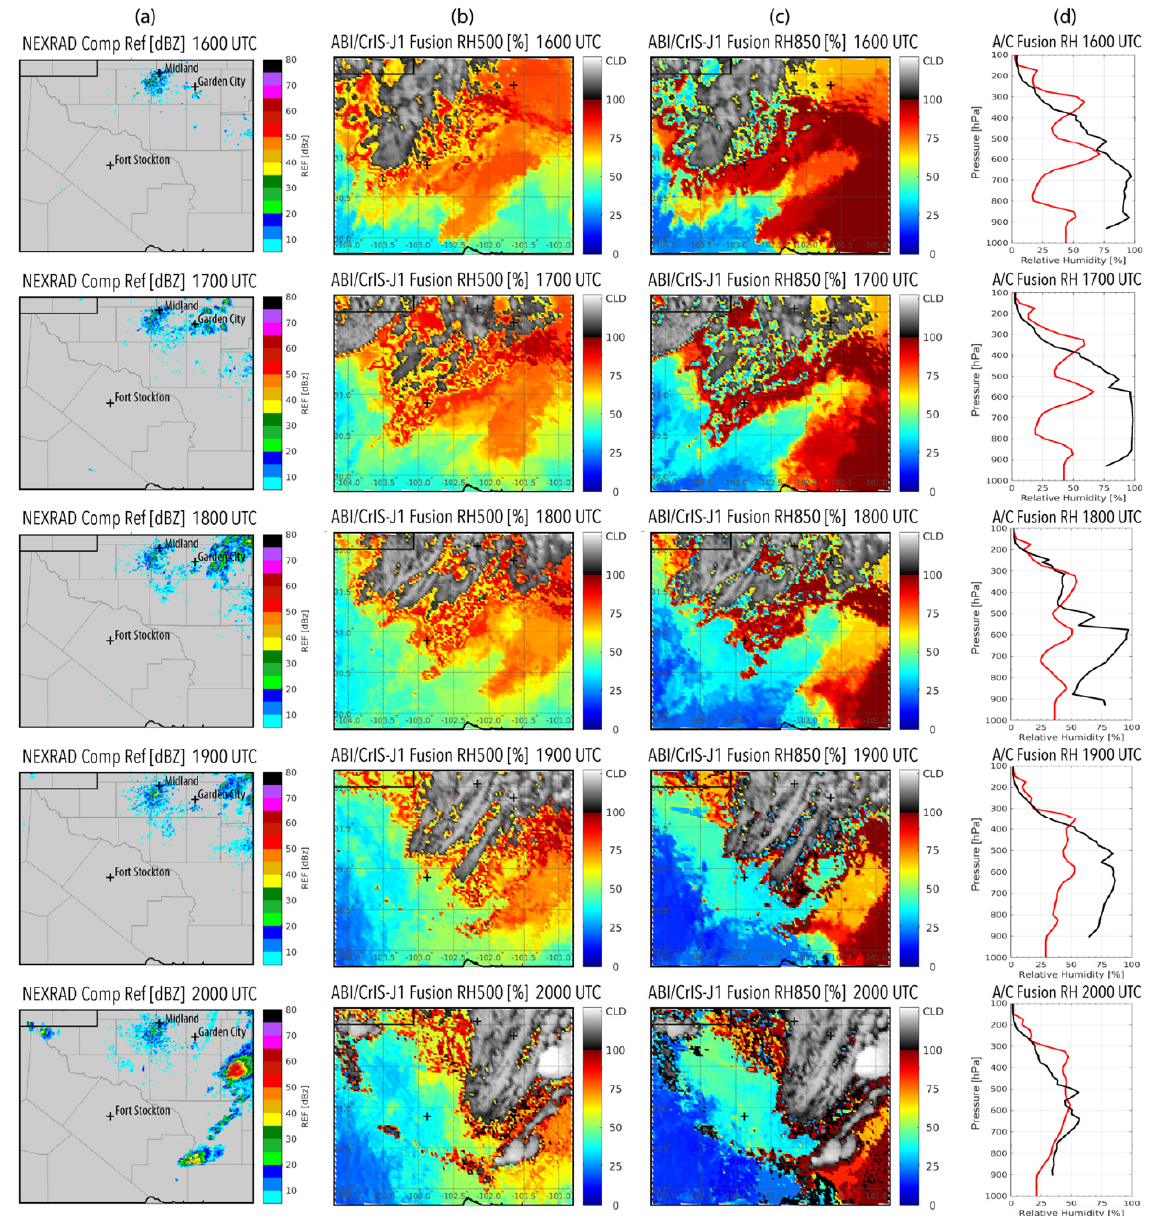
Figure 11. ( a ) Regional NEXRAD composite reflectivity [dBZ]; ( b ) ABI/CrIS fusion RH at 500 hPa; ( c ) ABI/CrIS fusion RH at 850 hPa; and ( d ) ABI/CrIS-J1 fusion RH profiles (black) and RAP RH profiles (red) for Fort Stockton hourly from 1600 UTC to 2000 UTC on 24 May 2022 over parts of western Texas (black crosses indicate locations of Midland, Garden City and Fort Stockton, TX).